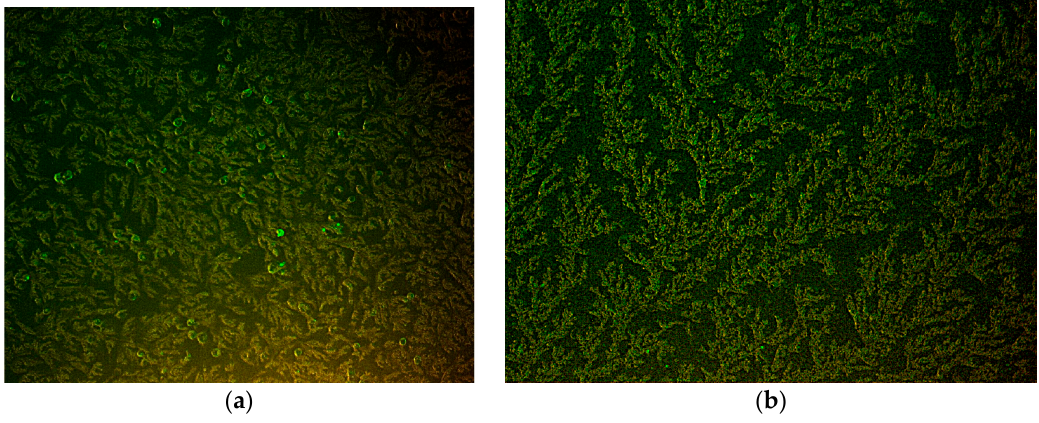
Figure 4. Indirect immunofluorescence of assay of PK-15 cells infected with PPV. ( a ) Infected cells fluoresced green, and ( b ) control cells stained in the same manner (200×